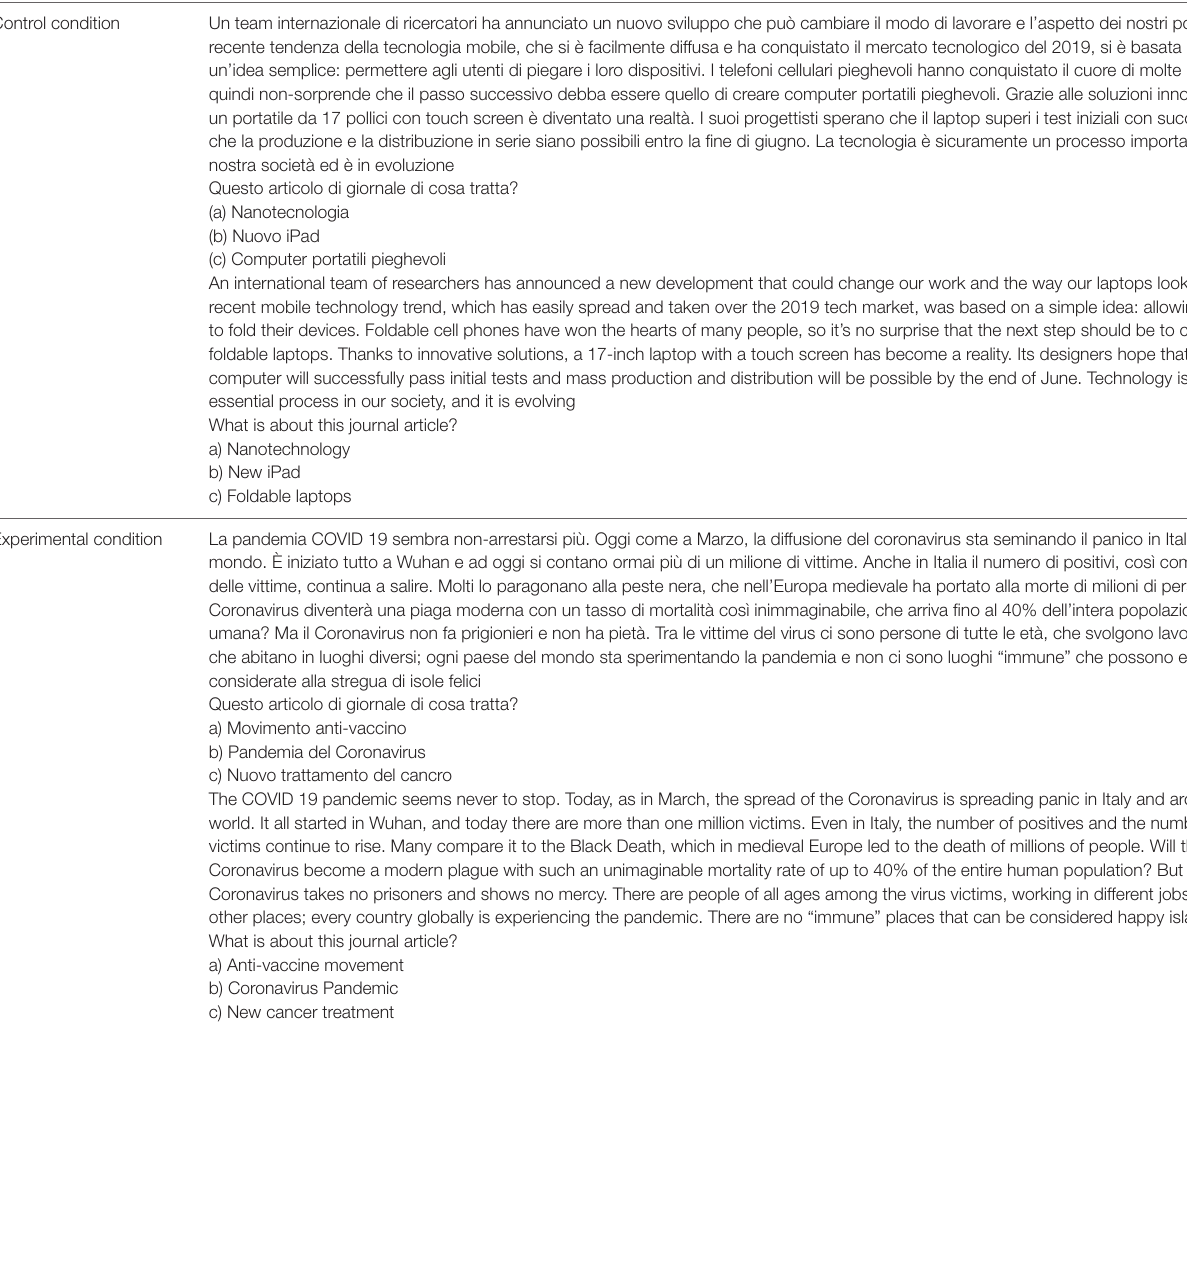
TABLE A1 | Italian and English versions of the stimuli used in the study. Control